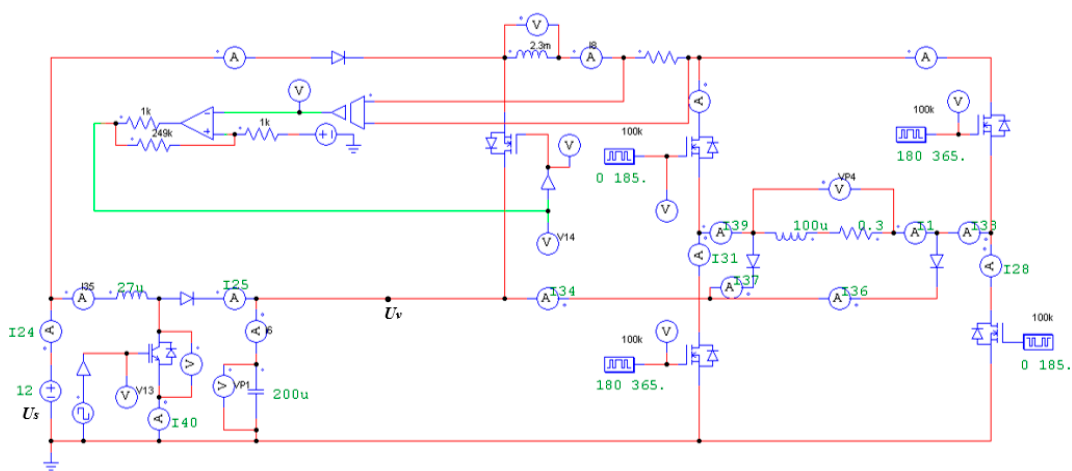
Figure 4. Simulation model of constant current and voltage clamping control circuit.